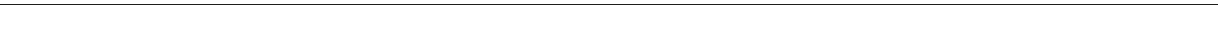
Fig. 4 Removing the negative feedback loop creates a noise-resistant environmental timer in a Prochlorococcus -like system. a Comparison of cell volume and KaiC copy number in Prochlorococcus marinus vs. Synechococcus elongatus . Copy number (inset) determined by quantitative western blot ( n = 3). b Prochlorococcus has a simpli fi ed Kai architecture that lacks kaiA . c Top: western blot time course showing Prochlorococcus KaiC (ProKaiC) phosphorylation in cultures incubated in light-dark cycles followed by constant light or constant dark. Bottom: quanti fi cation of ProKaiC phosphorylation. d Comparisons of model architectures corresponding to Synechococcus (left, strong feedback) and Prochlorococcus (right, no feedback). e Simulations of Kai systems with strong feedback (left) and no feedback (right) in light-dark cycles (shaded regions), followed by constant light at high copy number (top, 14,400 KaiC copies) and low copy number (bottom, 450 KaiC copies). “ KaiC state ” indicates the average position of KaiC molecules in the oscillator loop. f Mutual information between the clock and time of day during light-dark cycles in the presence of environmental fl uctuations (see Supplementary Information). Stable oscillations occur for feedback strength above 0.83 (dashed line). g Feedback strength that maximizes mutual information as a function of KaiC copy number. Above the dashed line, the system shows self-sustaining circadian rhythms. Marker colors correspond to the colorbar in